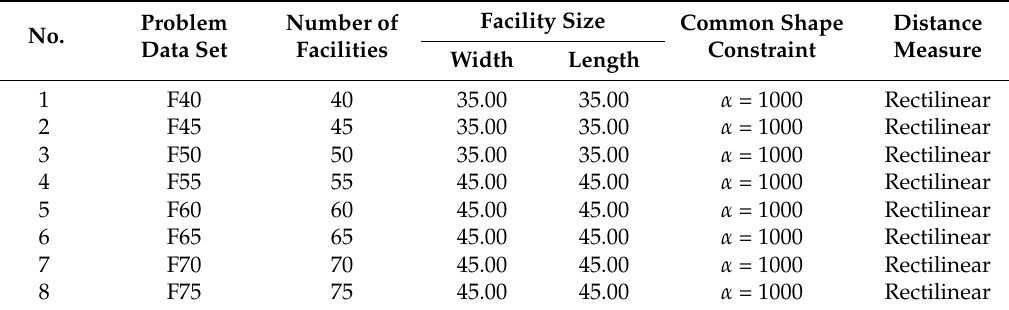
Table 3. Our added data of test problem sets.